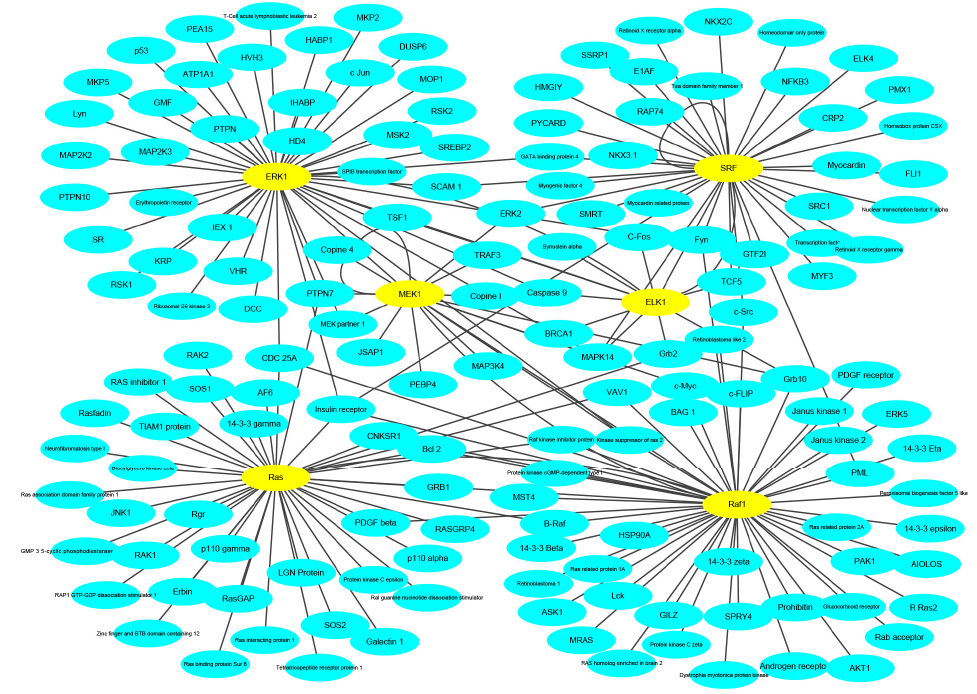
Figure 6. The prediction results of multi-core network.